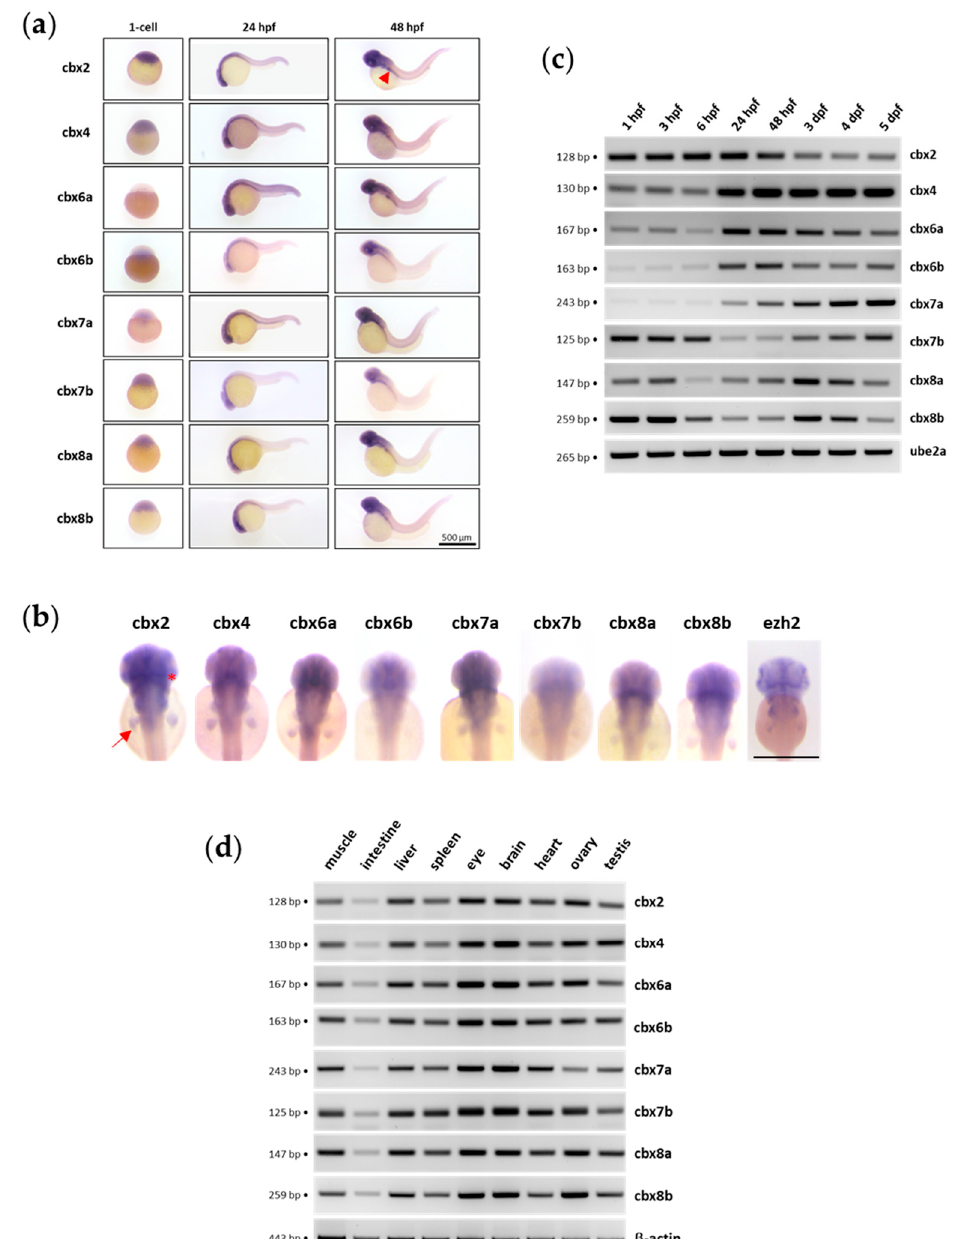
Figure 8. Expression of the cbx family members in zebrafish. ( a ) In situ hybridization at the 1-cell stage, 24 hpf and 48 hpf showing maternally provided transcripts (1-cell stage) and zygotic mRNA distribution at 24 and 48 hpf. The red arrowhead shows the gut. ( b ). Dorsal view of the anterior region of embryos at 48 hpf after in situ hybridization. The arrow shows the pectoral fin buds and the asterisk the midbrain–hindbrain boundary. Scale bar is 500 µ M. ( c ) RT-PCR experiment showing the detection of cbx2 (n = 3), cbx4 (n = 3), cbx6a (n = 2), cbx6b (n = 2), cbx7a (n = 3), cbx7b (n = 4), cbx8a (n = 3) and cbx8b (n = 3) transcripts at 1 hpf, 3 hpf, 6 hpf, 24 hpf, 48 hpf, 3 dpf, 4 dpf and 5 dpf. Ube2a is used as a control. The size of the amplicons is indicated. ( d ) RT-PCR experiment showing cbx transcripts in adult zebrafish tissues (n = 2). Beta-actin is used as a control. The size of the amplicons is indicated. All RT-PCR agarose gels are shown in Supplementary File